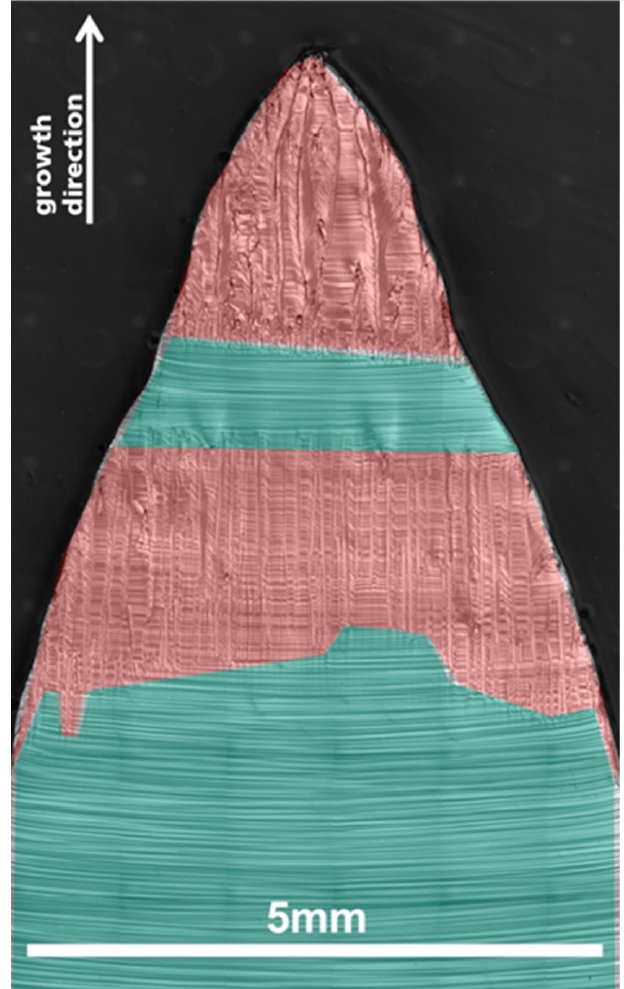
Figure 10. Microscope image of a vertical cut of an etched <100>-oriented silicon sample. During the last portion of the crystal growth process, the interface first becomes morphological unstable, recovers for a short time period, and becomes unstable again. The instability regions are marked in red, the stability regions in green. Thus far, the experimental results agree very well with existing theories about facetted growth. However, unexpected phenomena were also observed which cannot be explained conclusively by existing theories. Figure 11 shows microscope images of vertical cuts of three etched silicon samples to illustrate the evolution of the central facet in the <111>- oriented crystals. In all cases, the translation velocity was 1 mm/min. In the dislocation-free sample, which was grown by the FZ method, the diameter of the central facet was very stable along the growth direction (Figure 11, left). In the dislocation-containing sample, which was grown by the ZM method, the diameter of the central facet fluctuated aperi- odically but with distances between major amplitudes corresponding to around 0.025 Hz (Figure 11, middle). A repetition of the experiment reproduced the results (Figure 11, right). Such fluctuations were not observed in ZM crystals grown at higher translation